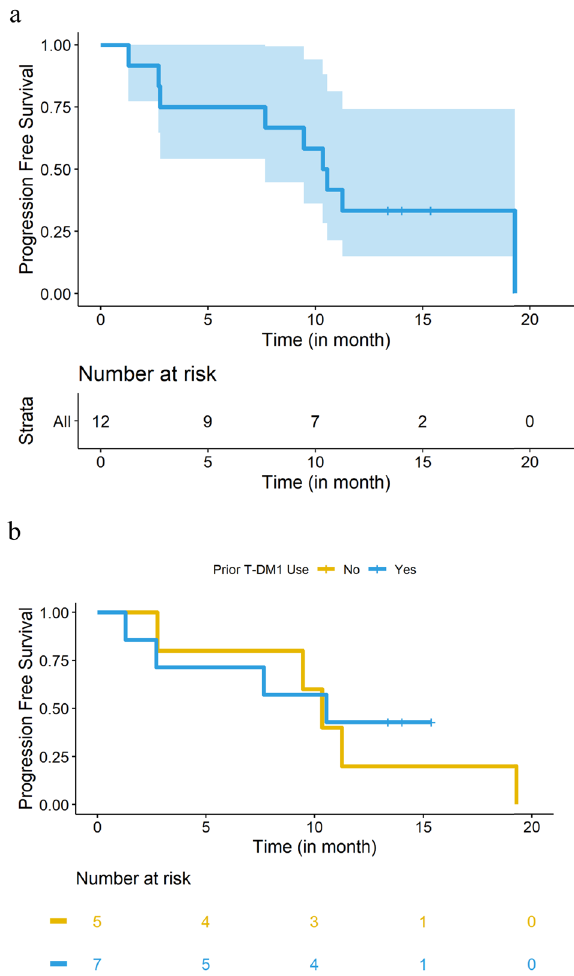
Fig. 2 Progression-free survival (PFS) results. a Median PFS summarized in a Kaplan – Meier plot. Median PFS was 10.4 months (95% CI [2.7 – 19.3]). b Median PFS summarized in a Kaplan – Meier plot, strati fi ed by prior T-DM1 use. The median PFS for patients with and without prior T-DM1 use was 10.5 months (95% CI [1.3-not reached]) and 10.3 months (95% CI [2.8 – 19.3]),